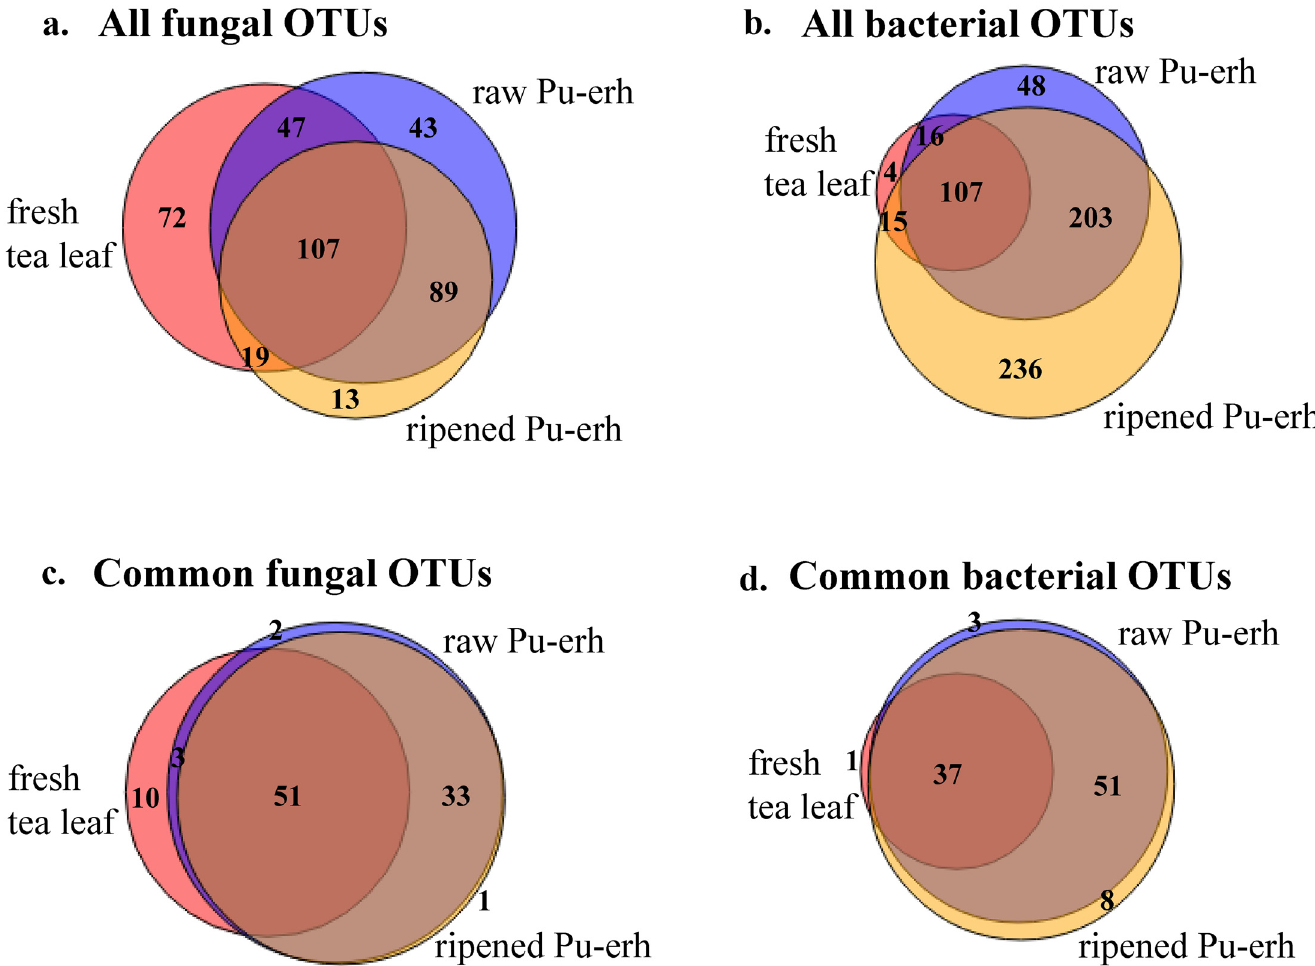
Fig 1. OTU overlap among fresh tea leaves (red), raw (blue) and ripened (orange) Pu-erh tea samples. Venn diagrams illustrate the number of unique and shared fungal (a, c) and bacterial (b, d) OTUs. We compared both the total OTUs (a, b) and just the first 100 most abundant OTUs (c, d) in the fungal/bacterial datasets.